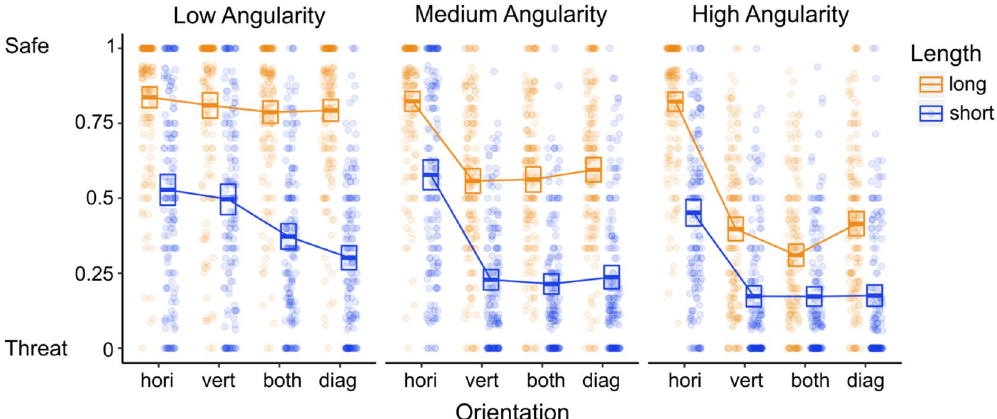
Figure 5. Average safe and threatening scores as a function of image contour features. The boxes represent the 95% confidence intervals. The dots represent individual ( N = 157) average values per